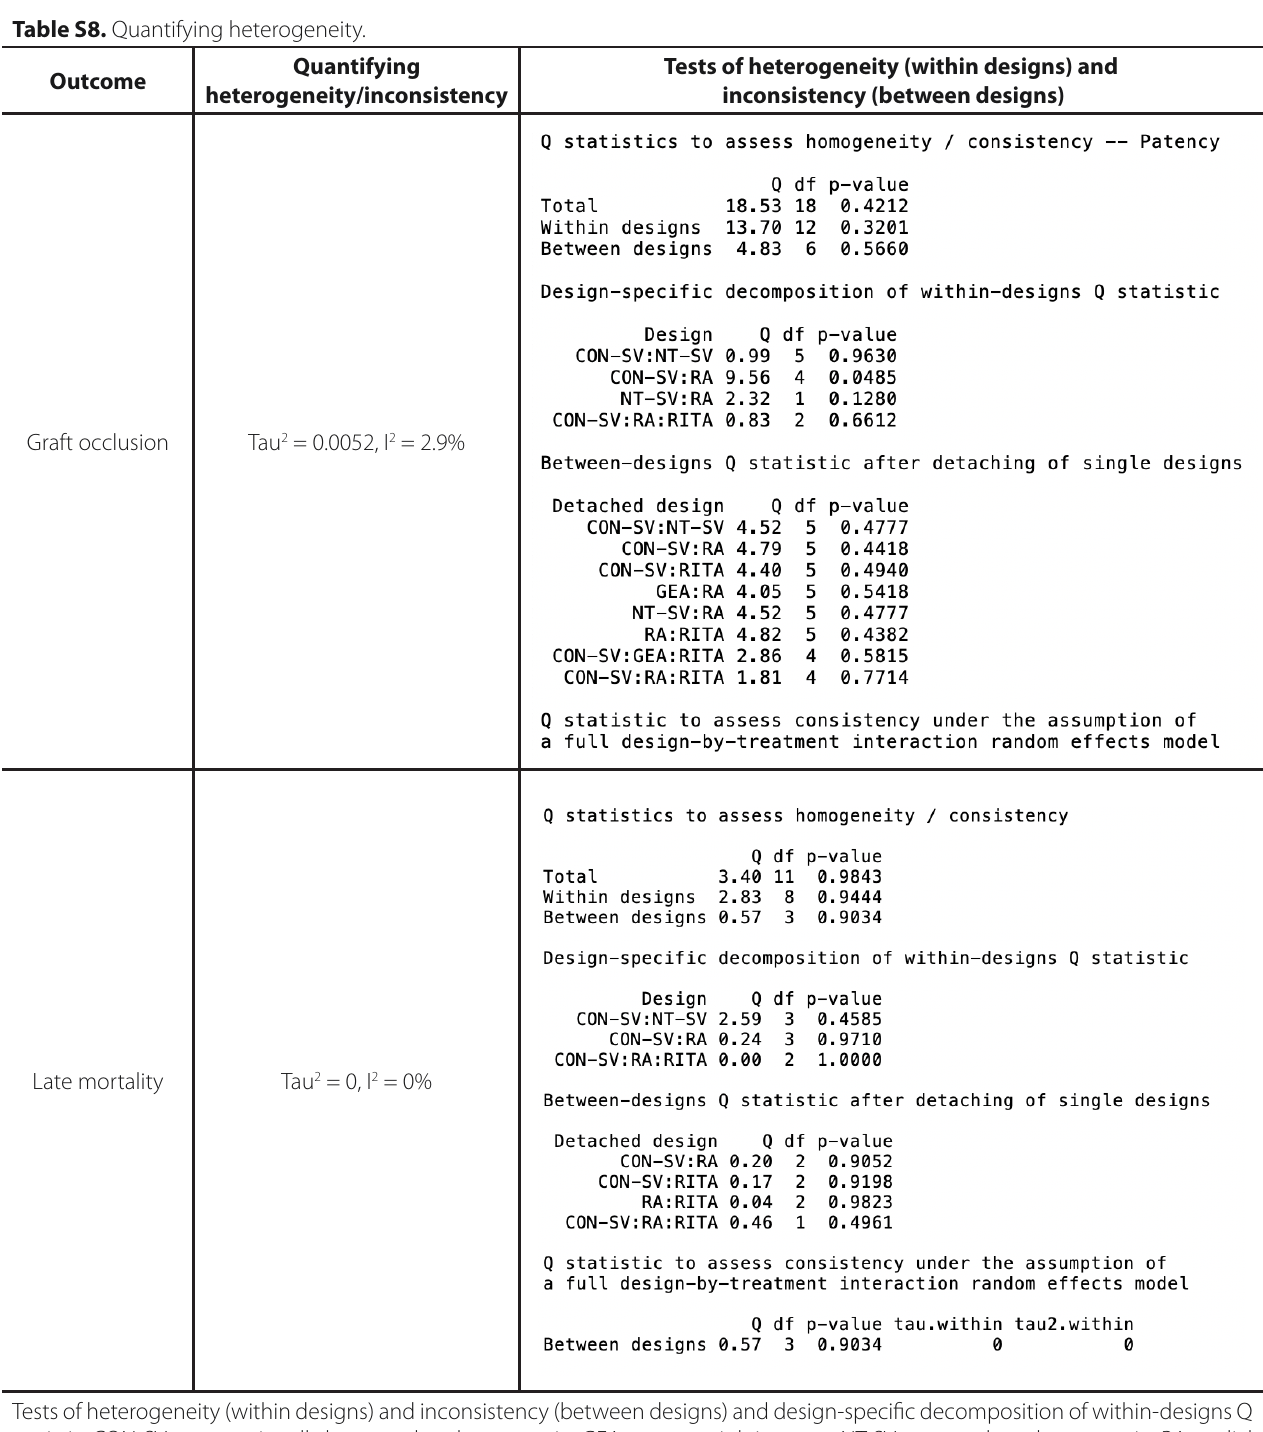
Table S8. Quantifying heterogeneity. Quantifying Outcome heterogeneity/inconsistency